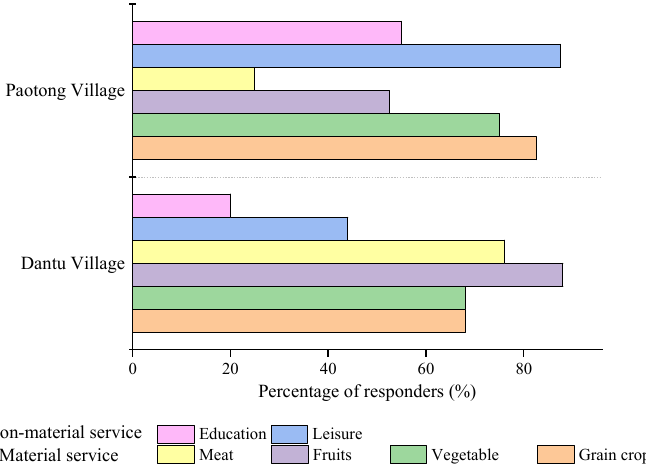
Figure 8. The perceived goods and services delivered to the urban market in Paotong Village and Dantu Village.